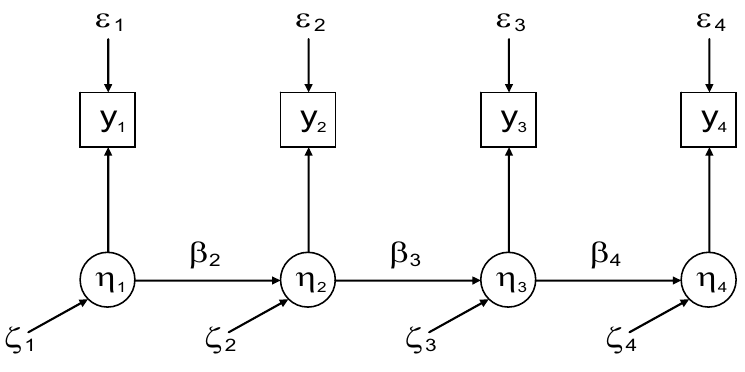
Figure 5 – The SIMPLEX model path